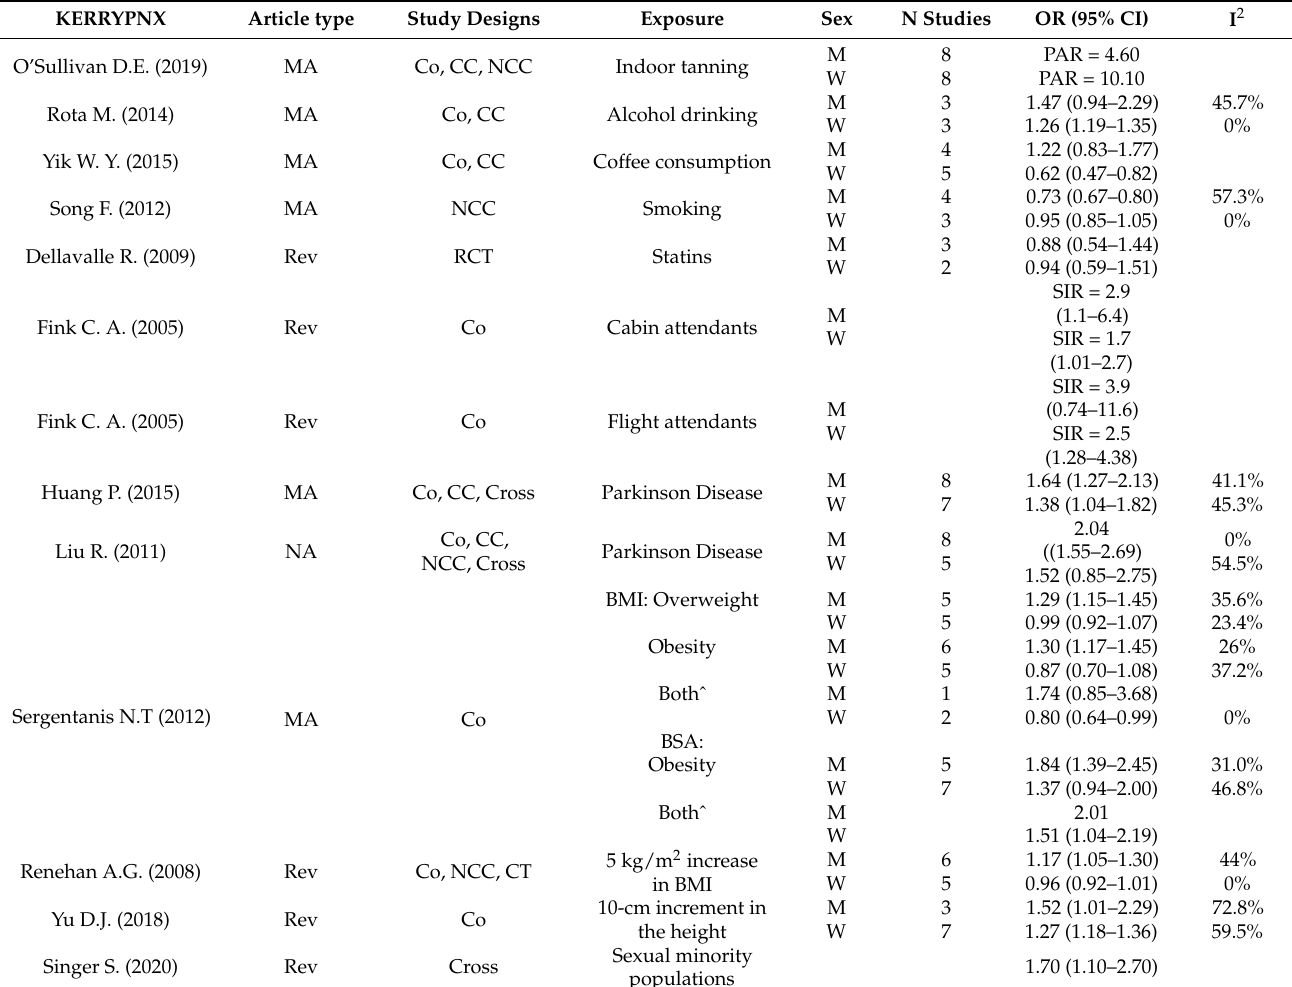
Table 1. Studies evaluating the incidence of